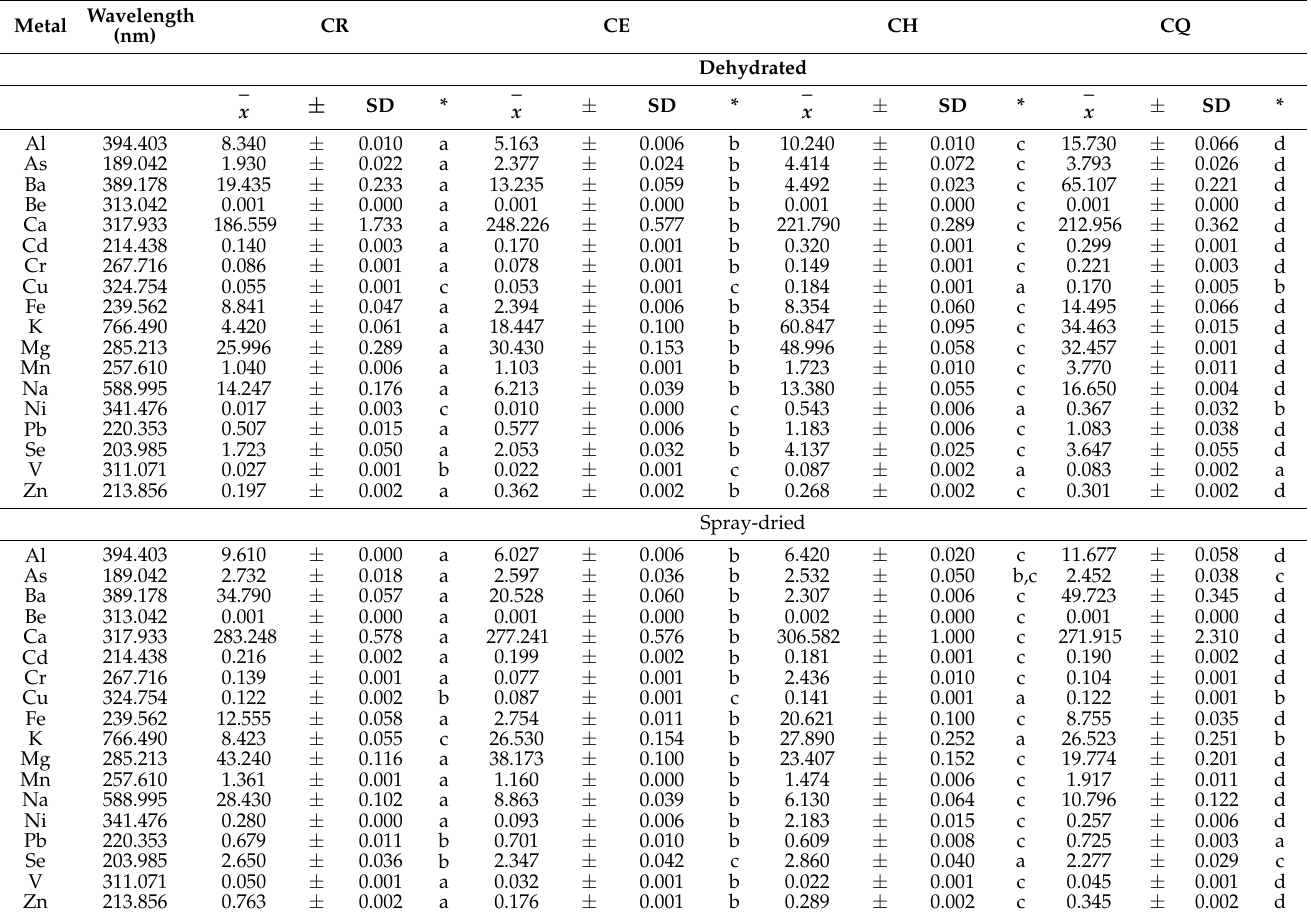
Table 10. Metals in dehydrated and spray-dried